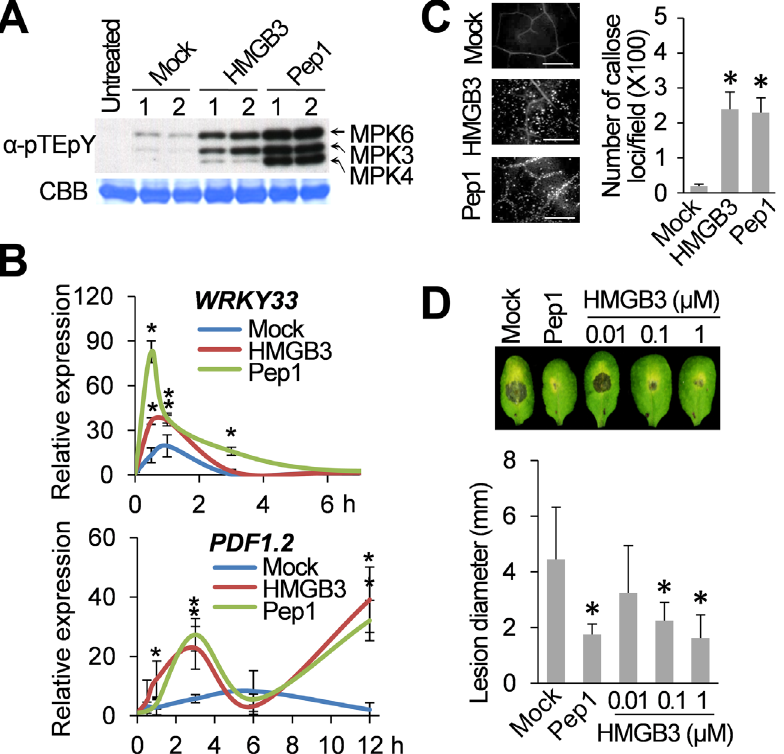
Fig 1. Extracellular HMGB3 activates innate immune responses. A. HMGB3- or Pep1-induced MAPK activation in Arabidopsis. Leaves were collected 15 min after infiltration with water containing either 1 μ M recombinant HMGB3 (HMGB3) or Pep1 peptide (Pep1) for the MAPK activation assay. Activation of MPK3, MPK4, and MPK6 by MAPK kinase-mediated phosphorylation of the TEY sequence was detected with α - pTEpY antibody using immune-blot (IB) analyses. Ribulose-1,5-bisphosphate carboxylase/oxygenase (Rubisco) large subunit protein stained with Coomassie Brilliant Blue (CBB) served as a loading control. 1 and 2 denote independent biological replicates. B. RT-PCR analysis of WRKY33 (upper panel) and PDF1 . 2 (lower panel) expression at the indicated times after infiltration with water containing either 0.1 μ M HMGB3 or Pep1. Expression levels were plotted relative to the expression in untreated leaves. Data are the mean ± SD (n = 4). C. HMGB3- or Pep1-induced callose deposition in Arabidopsis. Leaves were stained with aniline blue 15 h after infiltration with water containing either 0.1 μ M HMGB3 or Pep1. Representative pictures are shown in the left panel. Bars = 100 μ m. Data are the mean ± SD (right panel, n = 20). D. HMGB3- or Pep1-induced resistance to B . cinerea . Leaves were infiltrated with water containing the indicated concentrations of HMGB3 or 1 μ M Pep1 one day before B . cinerea inoculation. Representative disease symptoms at 3 days post infection (dpi) are shown in the upper panel. Data corresponding to this time point are presented as the mean ± SD (lower panel, n = 6). Leaves infiltrated with water served as mock control in all experiments. Asterisks in B , C , and D indicate significant differences from the mock-treated leaves ( t test, P <